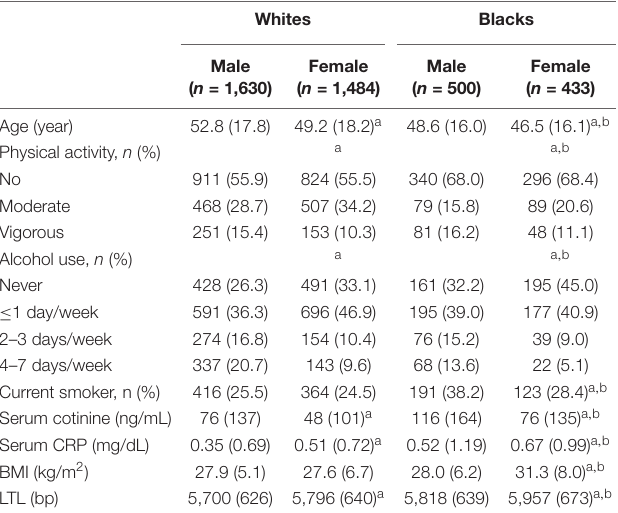
TABLE 1 | Descriptive data of study participants by race and sex.